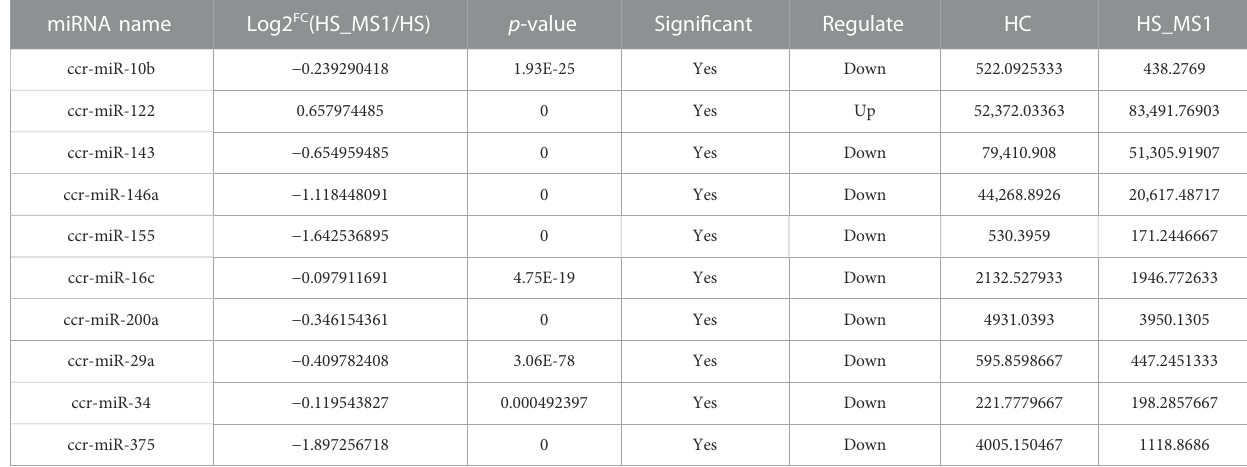
TABLE 4 Differential expression of miRNAs in HC and HS_MS1 groups associated with insulin signaling pathway and insulin resistance of common carp (n = 6). miRNA